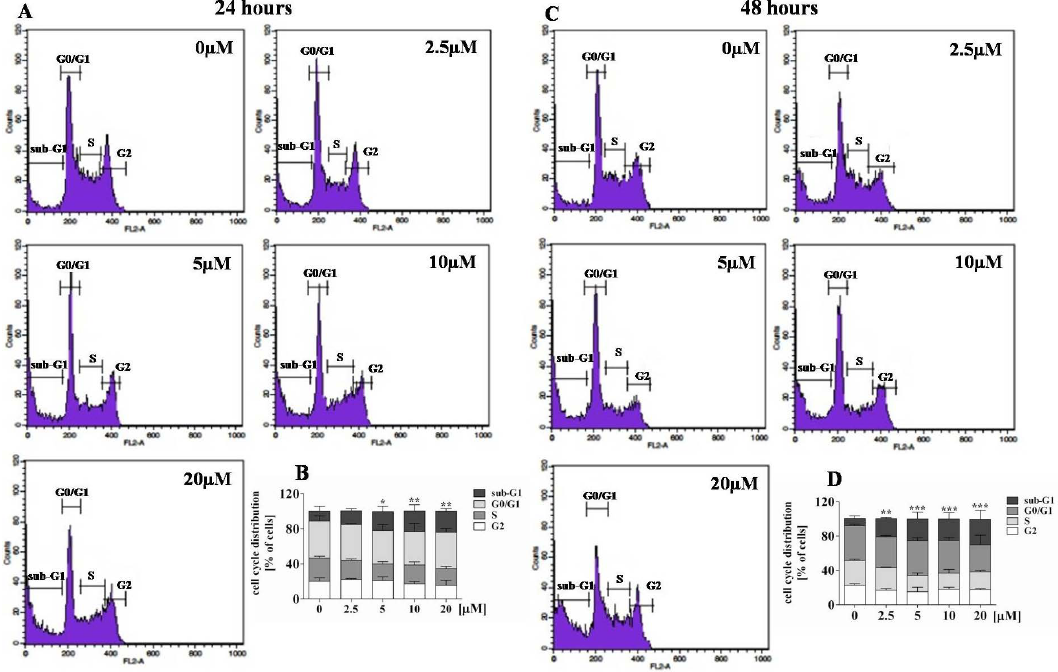
Figure 4. E ff ect of compound 3a on cell cycle distribution in the RPMI 8226 cell line. After the treatment with various concentrations of compound 3a for 24 and 48 h, the cells were stained with propidium iodide and analyzed by flow cytometry. Representative DNA histograms after 24-h ( A ) and 48-h ( C ) treatment. Statistical analysis of the percentages of cells in the sub-G1, G0 / G1, S, and G2 phases after 24-h ( B ) and 48-h ( D ) treatment. Data ( n = 6 for each concentration) are presented as the mean ± SD of three independent experiments; * p < 0.05, ** p < 0.01 and *** p < 0.001 in comparison to the control; one-way ANOVA